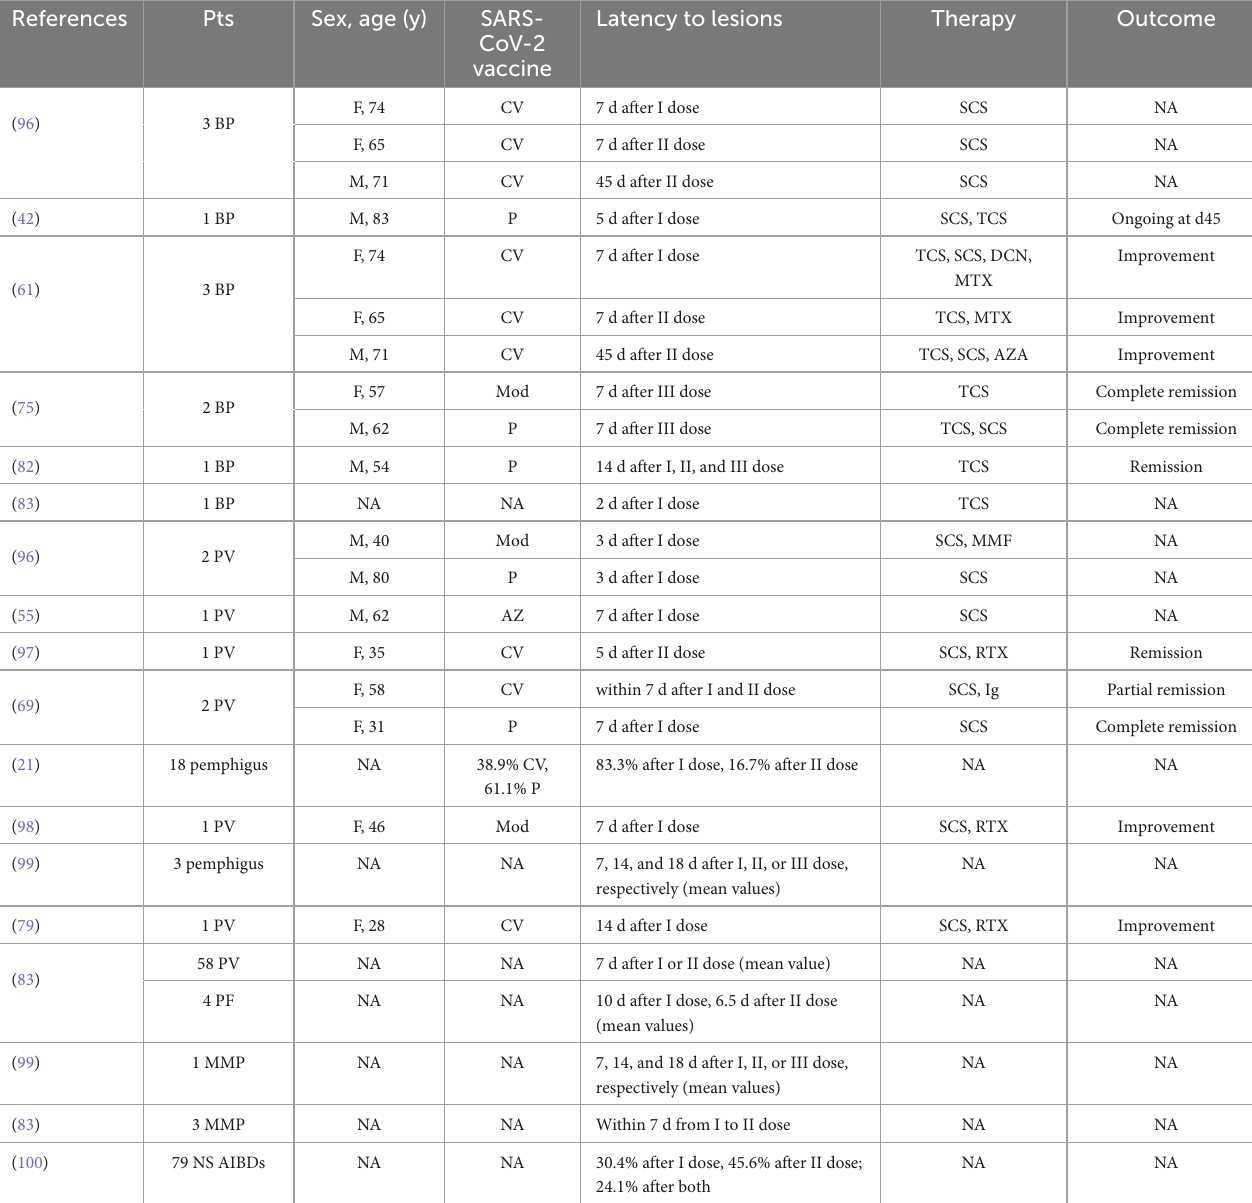
TABLE 2 Demographics, vaccines, latency time, and clinical features of AIBD patients reporting disease flare or worsening after COVID-19